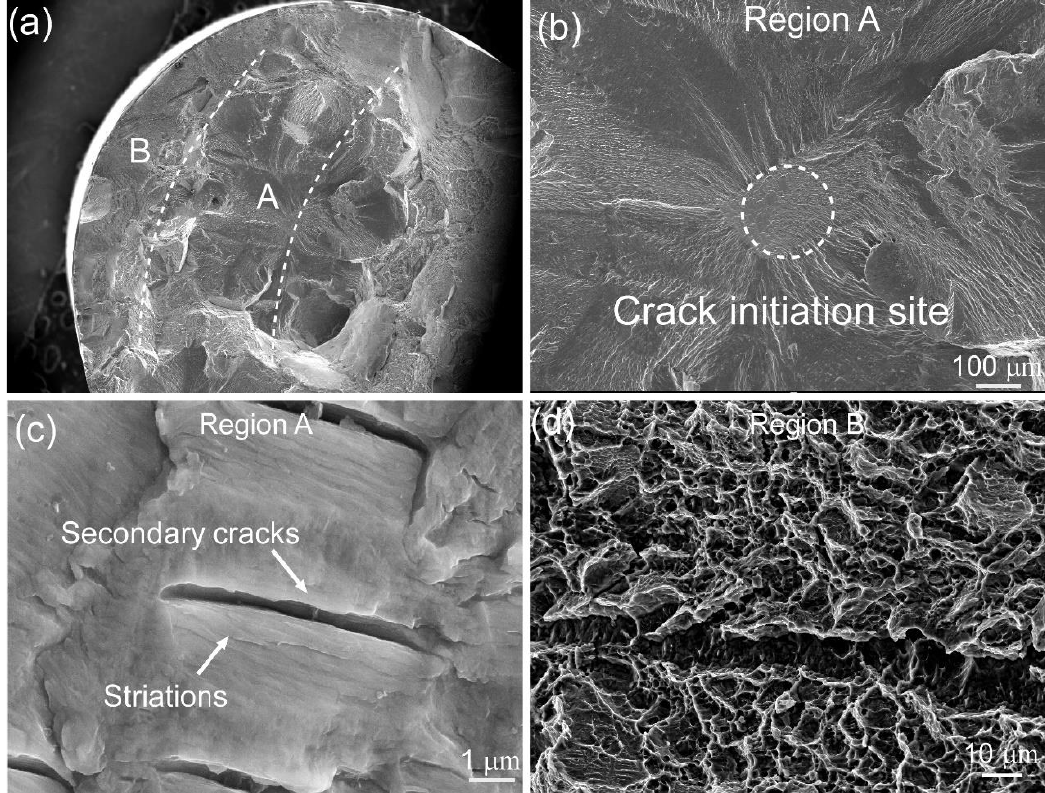
Figure 7. The longitudinal cross section and the fracture surface of the Ti55511 fatigue specimens (loading, 750 MPa; life, 8.29 × 10 6 cycles). ( a ) Macroscopic fracture surfaces, ( b ) the crack initiation site in Region A, ( c ) fatigue striations and secondary cracks in Region A, and ( d ) the dimple structures in Region B.